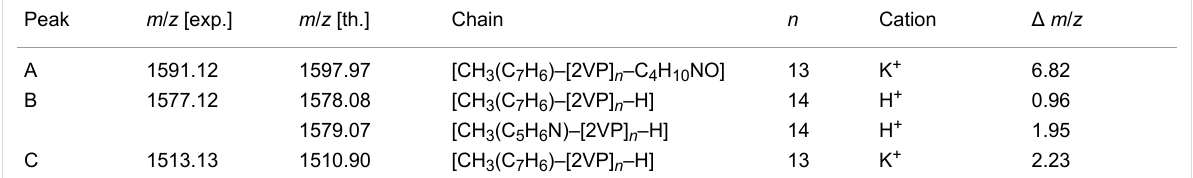
Table 1: End group determination of the macroinitiators via MALDI-TOF MS. Peak